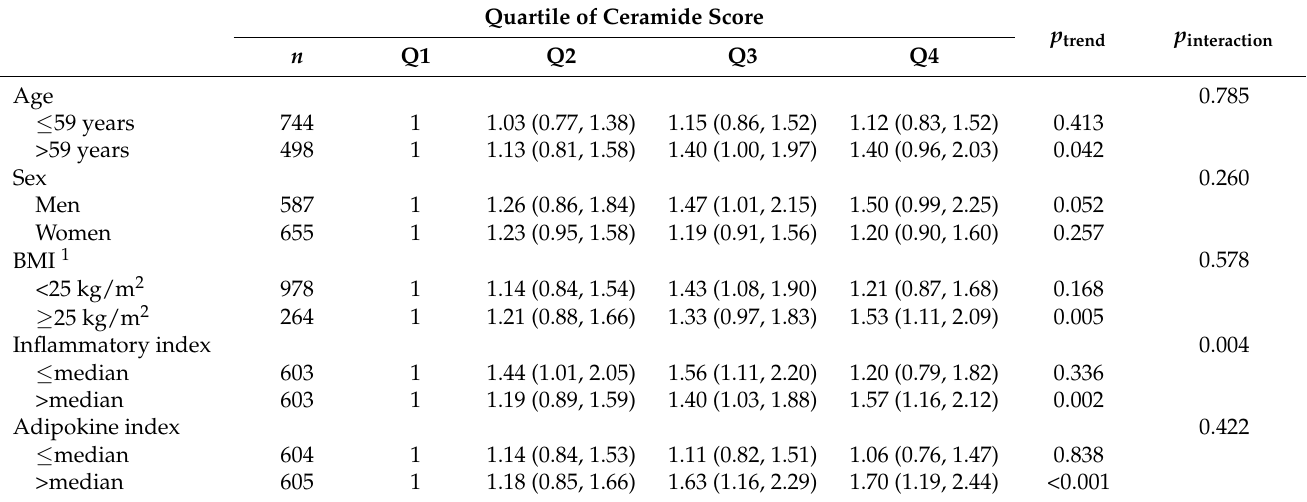
Figure 2. Correlations between sphingolipid scores and metabolic risk factors at baseline. Values were adjusted for age, sex, region (Beijing or Shanghai), and residence (urban or rural). *, p < 0.05; **, p < 0.01; ***, p < 0.001 after correction for multiple testing using the Benjamini–Hochberg method. CRP, C-reactive protein; dhCer, dihydroceramide; GSL, glycosphingolipid; HOMA-IR, homeostatic model assessment of insulin resistance; IL-6, interleukin-6; RBP4, retinol-binding protein 4; SM, sphingomyelin; SM (OH), sphingomyelin with one additional hydroxyl. Table 4. Stratified analysis of RR (95% CI) of incident metabolic syndrome according to quartiles of baseline sphingolipid